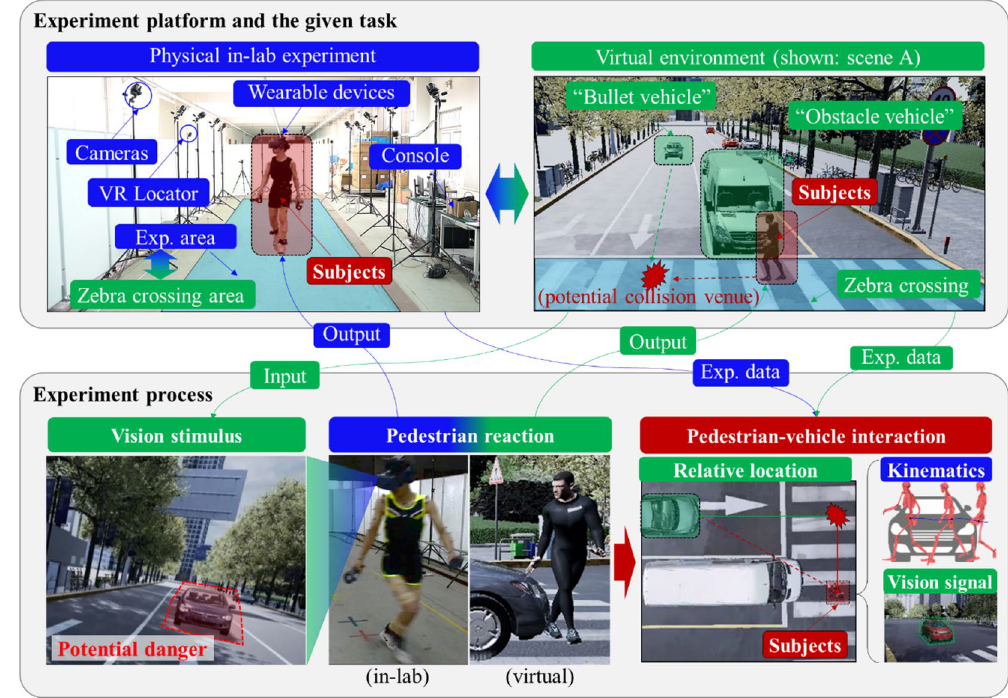
Figure 1. Overview of the experiment framework and the data flow (shown: lab experiment photos and captures of the virtual scene). In the virtual environment, “Obstacle vehicle” represents a vehicle that stopped in front of the zebra crossing and obstructed the pedestrian’s vision; “Bullet vehicle” represents a vehicle behind the obstacle vehicle that suddenly appeared and conflicted with the pedestrian.